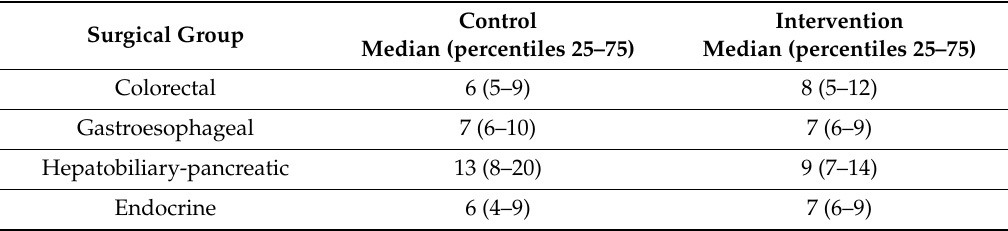
Table 2. Lengths of stay in relation to the surgery